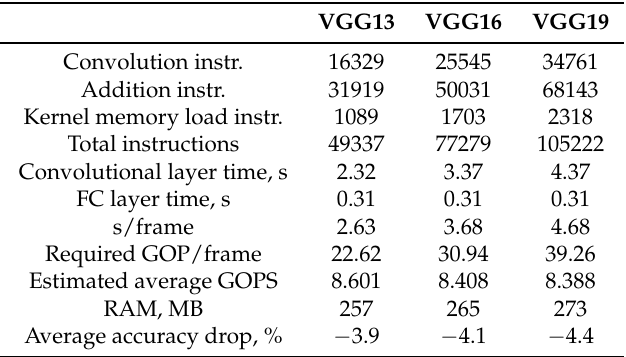
Table 4. Results of the CNN implementation on a Z-7020 FPGA.